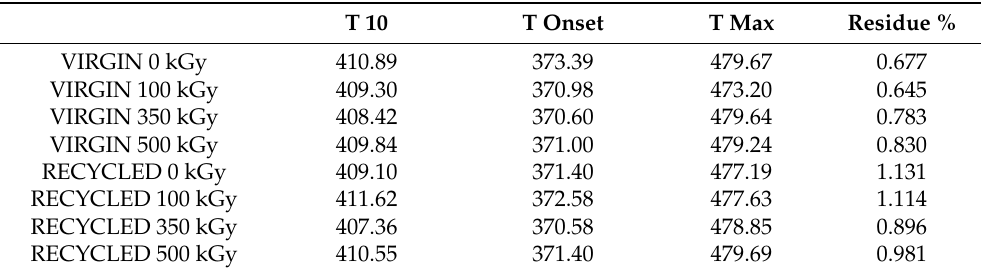
Table 5. Main characteristics of the TGA